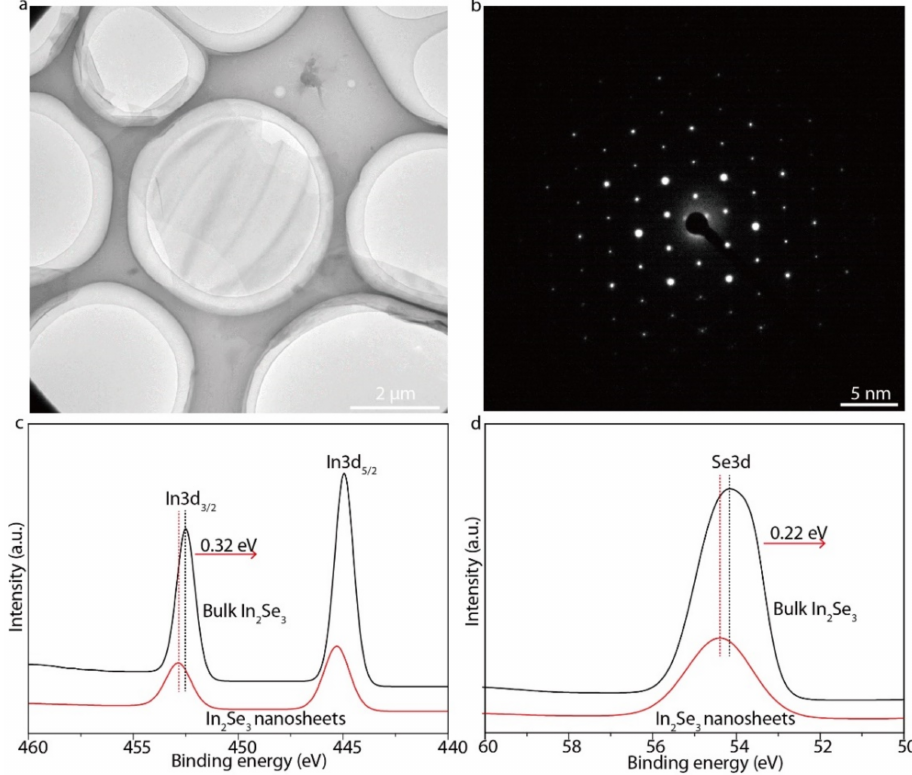
Figure 2. Characterizations of In 2 Se 3 nanosheets. ( a ) TEM image of In 2 Se 3 nanosheets. ( b ) Selected-area electron diffraction image of an In 2 Se 3 nanosheet. ( c ) Comparison of In 3d binding energies of electrochemically intercalated In 2 Se 3 nanosheets and bulk In 2 Se 3 . ( d ) Comparison of Se 3d binding energies of electrochemically intercalated In 2 Se 3 nanosheets and bulk In 2 Se 3